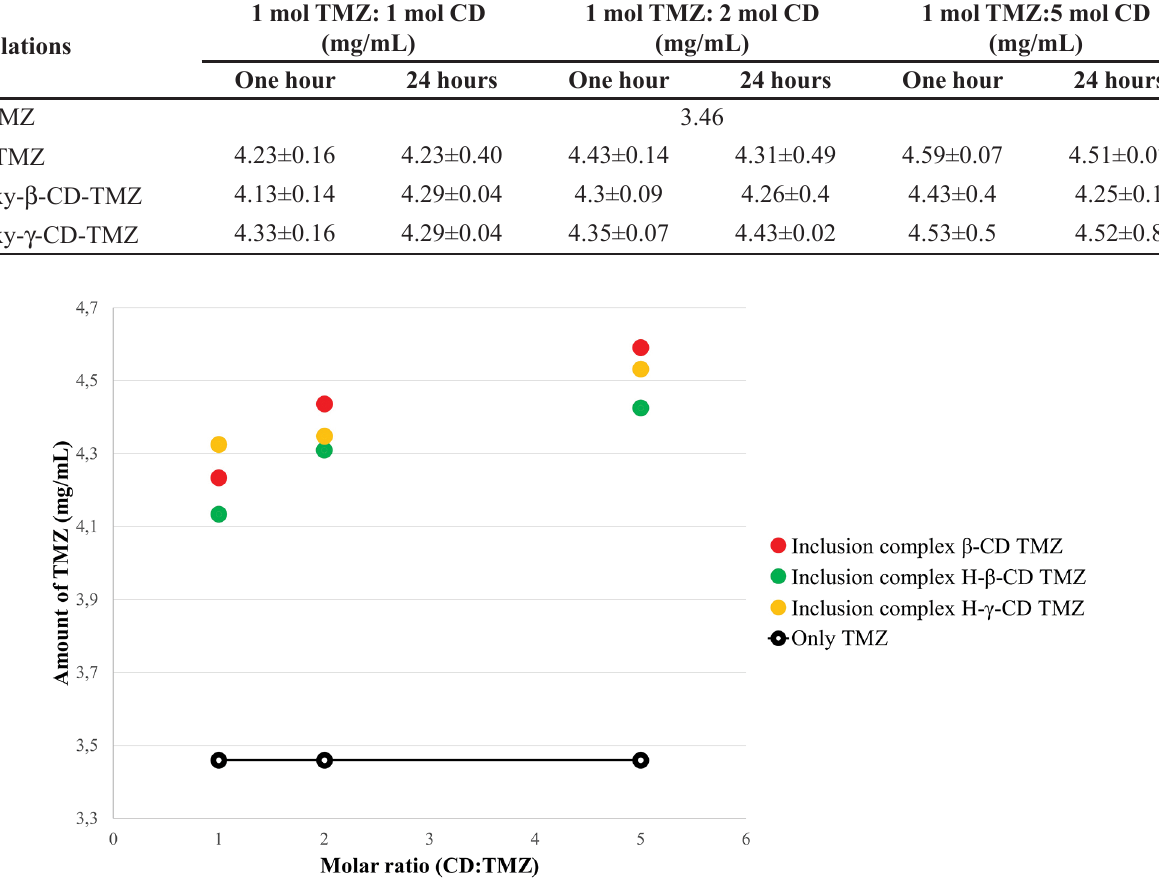
TABLE II - Amount of solubilized TMZ in mg/mL in 0.1 M HCl after the formation of inclusion complex after one hour and 24 hours